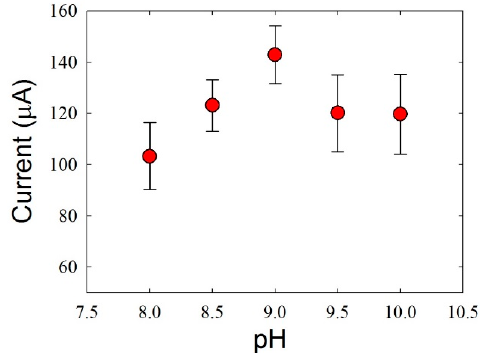
Figure 6. Oxidation currents based on the pH of the Tris buffer. The ITO electrodes were submerged in 1 mM DA for 30 min and then measured in 1 mM·HZ. The error bars indicate the standard deviations of at least three measurements.